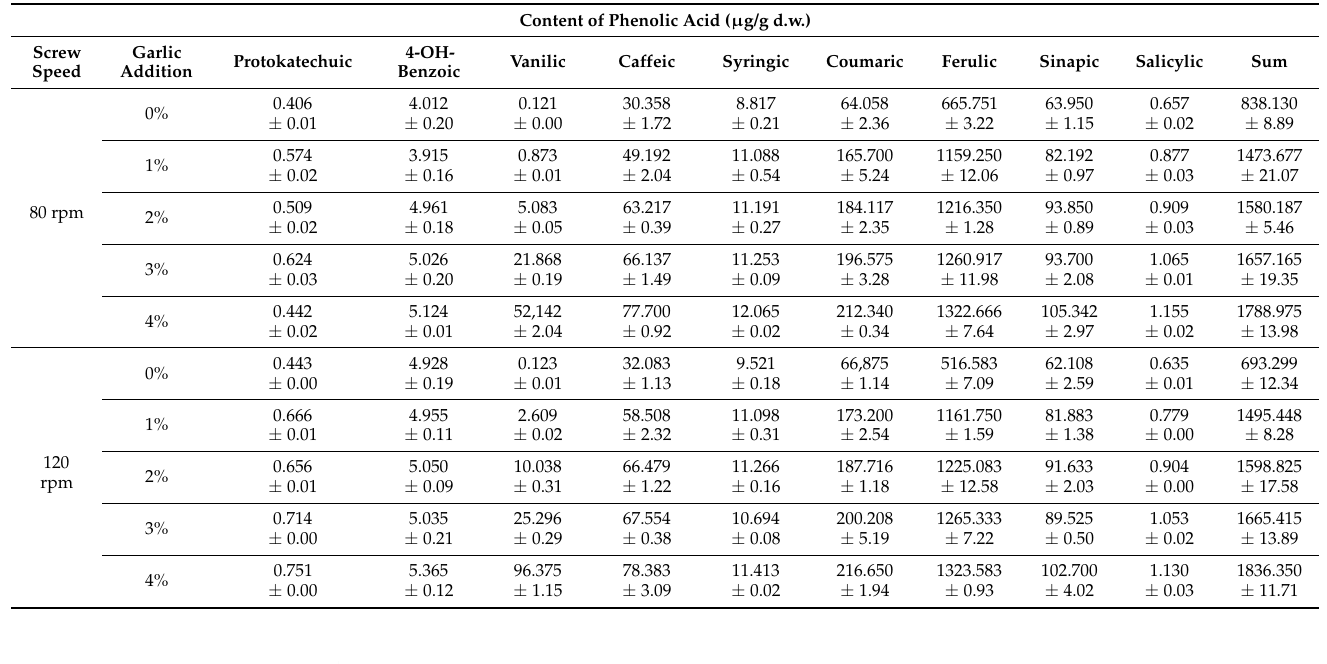
Table 2. The content of phenolic acids (after hydrolysis) in snacks enriched with wild garlic extruded at two different screw speeds (n = 3; mean ± SD). Content of Phenolic Acid ( µ g/g d.w.)